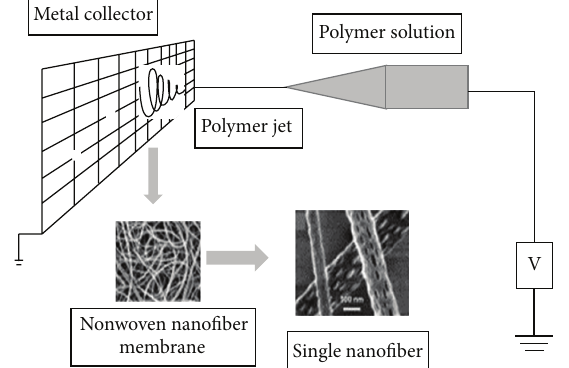
Figure 3: Nanofiber production using polymer solution in electro- spinning technique